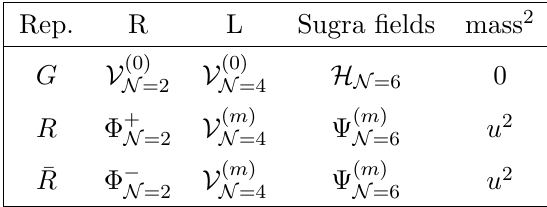
Table 2 . Fields and mass spectra for the CSS gauging of N = 8 supergravity with N = 6 residual supersymmetry. V (0) and V ( m ) denote massless and massive vector multiplets, while H N = N N = N N = N and (cid:9) ( m ) denote graviton and massive gravitini multiplets, respectively. (cid:8) (cid:6) N = N